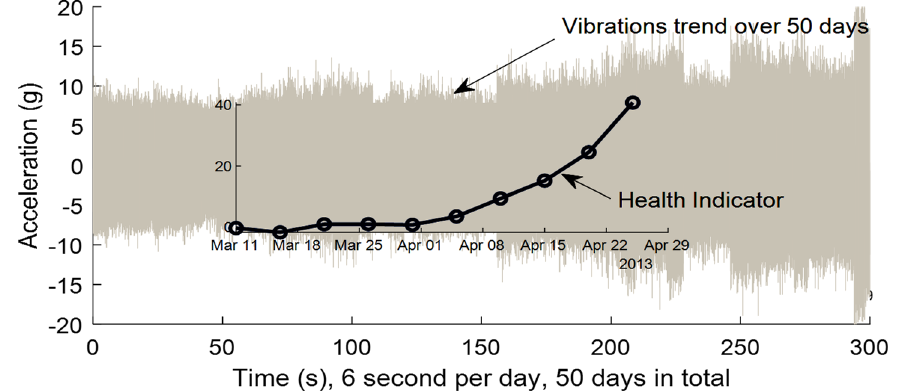
Figure 12. The vibration trend of the HSSB inner race fault: values of the kurtosis for 50 measurements. Reproduced from [49], IEEE.